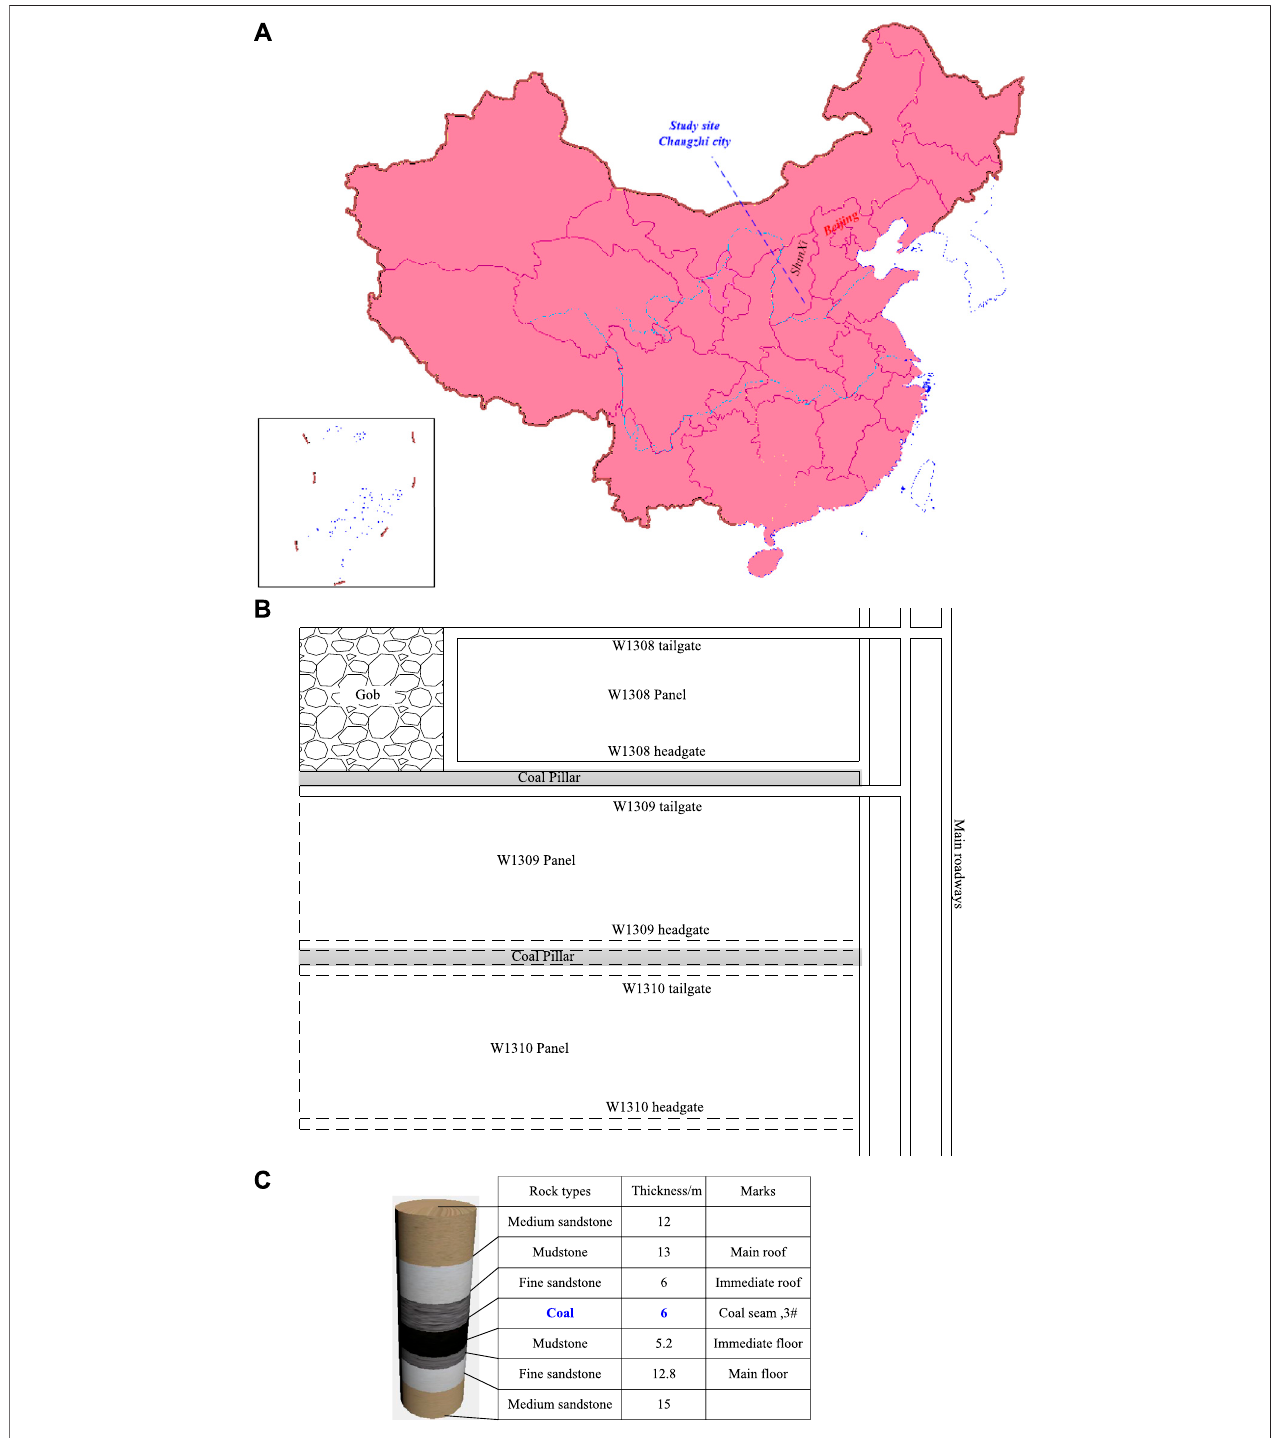
FIGURE2| Thegeographicallocationandpanelarrangementofthestudysite. (A) Thelocationofthestudysite; (B) Thepanelandroadwaylayoutofthestudysite; (C) The generalized stratigraphic column of the study site.